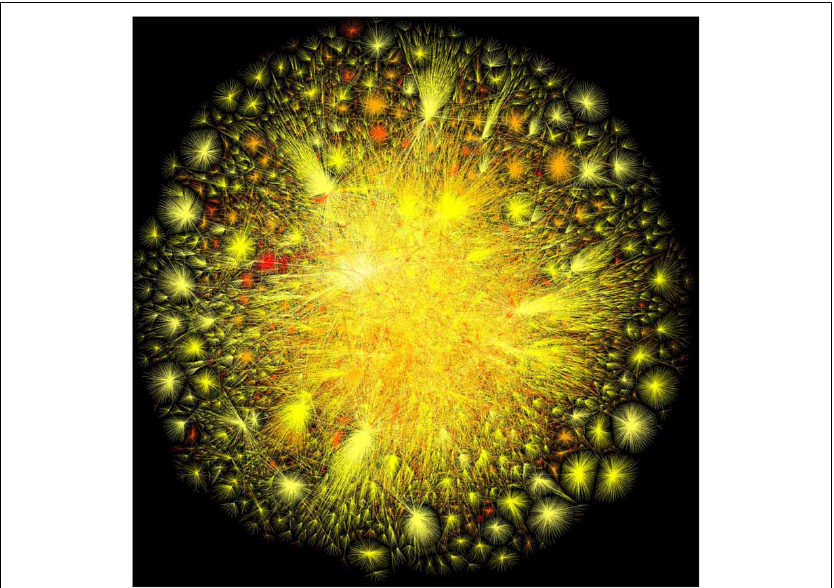
FIGURE 1 | Computer-generated image of internet connections world-wide (Global Brain). The conceptual similarities with the human brain are remarkable. Both networks exhibit a scale-free, fractal distribution, with some weakly-connected units, and some strongly-connected ones which are arranged in hubs of increasing functional complexity. This helps protect the constituents of the network against stresses. Both networks are “small worlds” which means that information can reach any given unit within the network by passing through only a small number of other units. This assists in the global propagation of information within the network, and gives each and every unit the functional potential to be directly connected to all others. Source: The Opte Project/Barrett Lyon. Used under the Creative Commons Attribution-Non-Commercial 4.0 International License